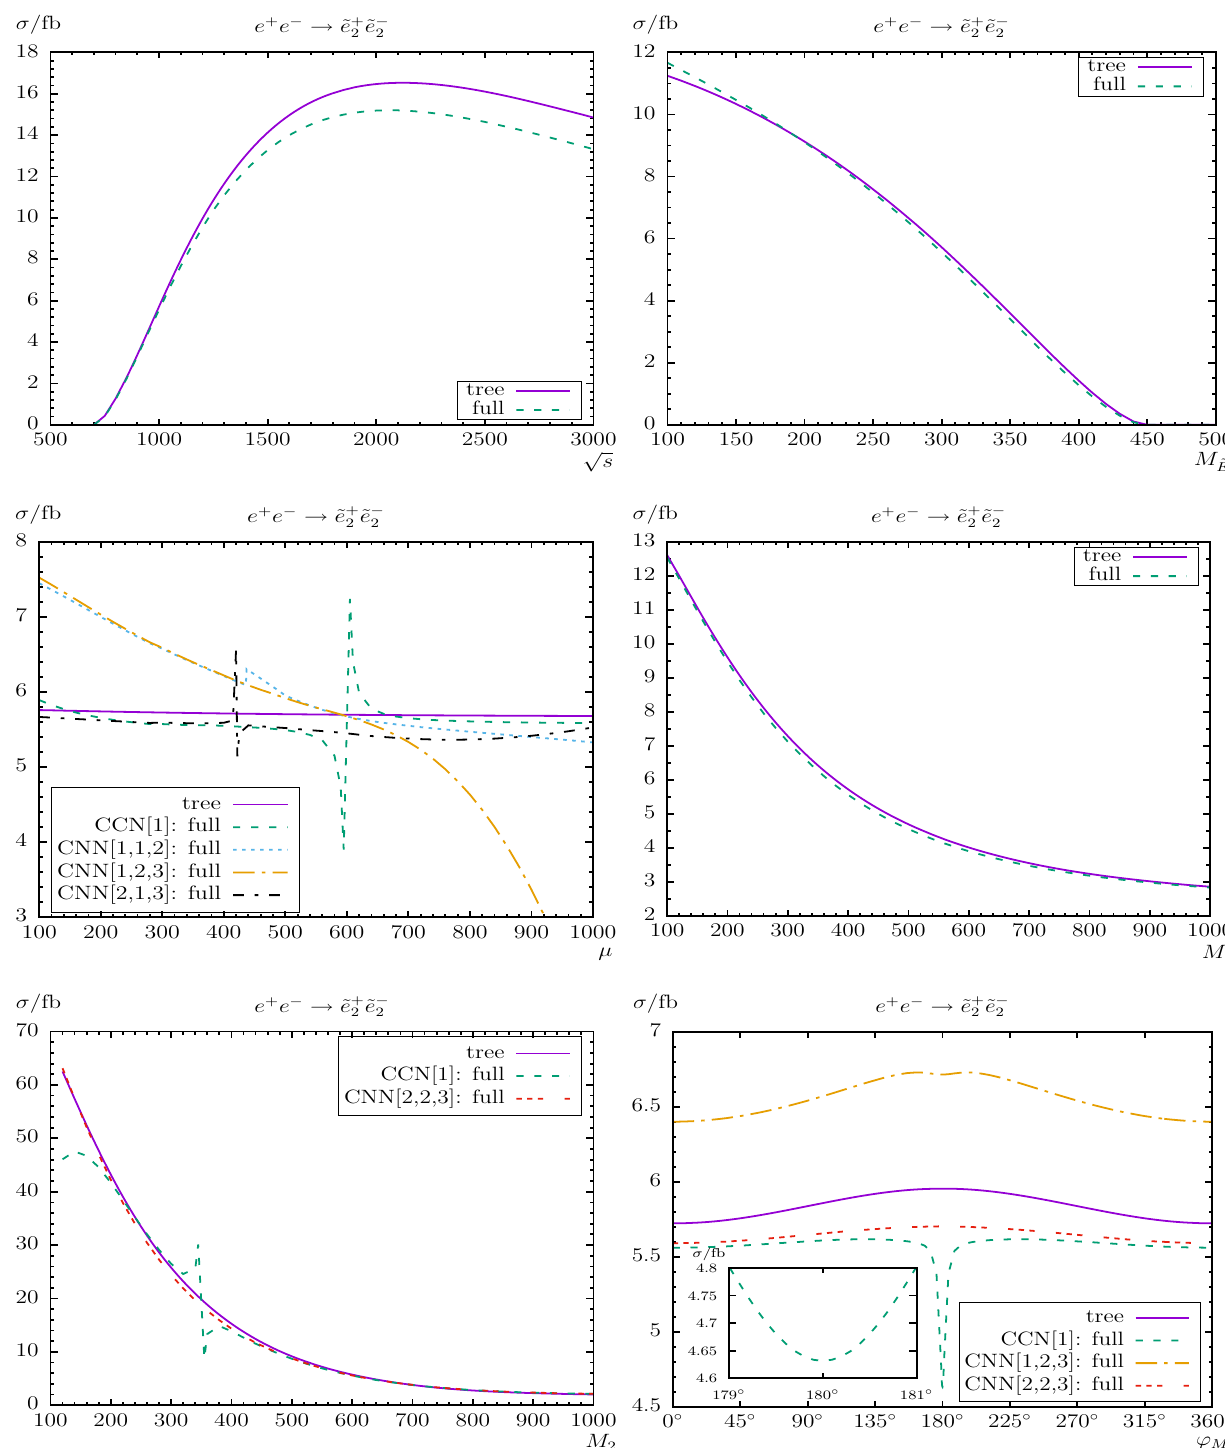
˜ e − ) . Tree-level and full one-loop corrected Fig. 11 σ( e + e − → ˜ e + (right) varied; the middle plots show μ (left) and | M 1 | (right) varied; 2 2 cross sections are shown with parameters chosen according to S ; see the lower plots show M 2 (left) and ϕ M √ s (left) and M ˜ Table 1. The upper plots show the cross sections with energies are in E